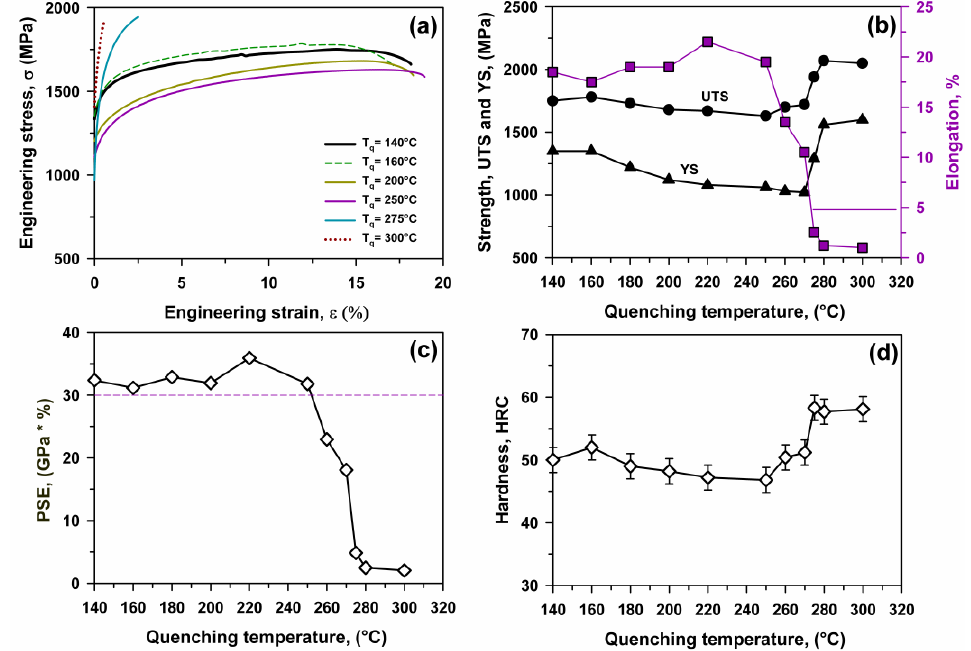
Figure 11. Typical engineering stress–strain curves ( a ), effect of quenching temperature on the tensile properties (the YS, UTS, elongation) ( b ), PSE ( c ), and hardness ( d ) of the Fe - 0.44C steel.